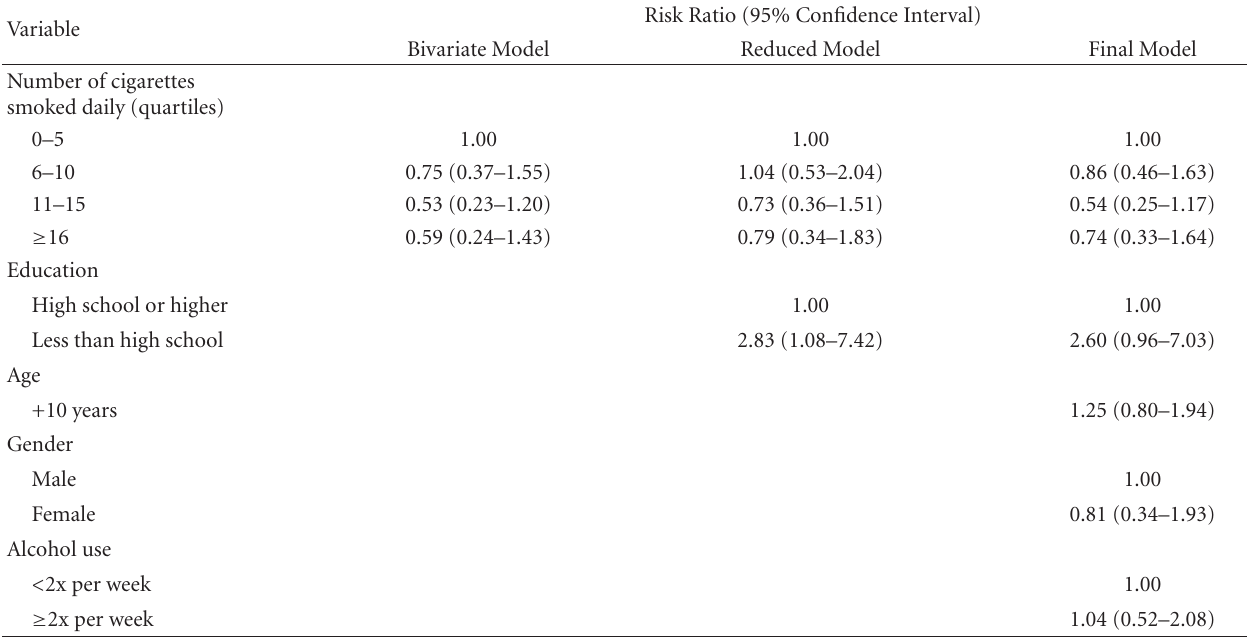
Table 3: Adjusted risk ratios for QFT conversion (IFN- γ ≥ 0.70 IU/mL) at 18 months based on multivariable Poisson regression models with robust variance; Tijuana, Mexico,